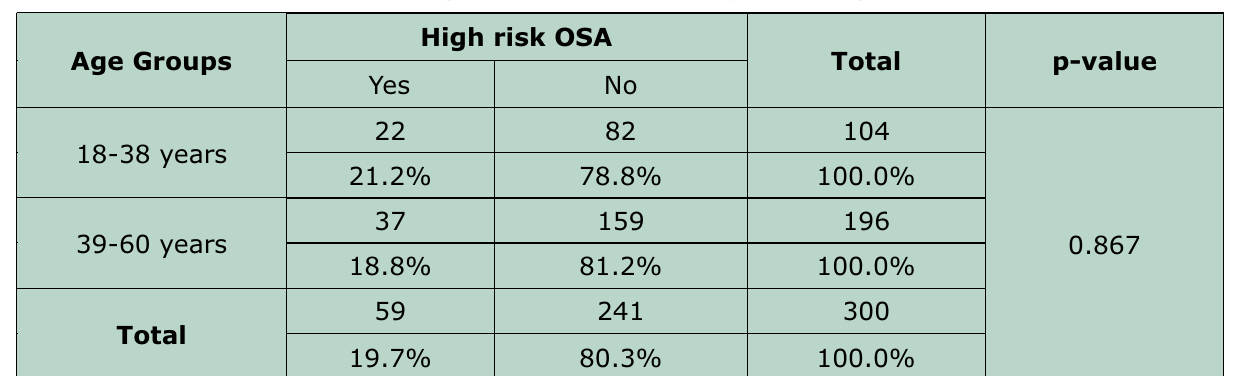
Table-IV: Stratification of High risk OSA with respect to